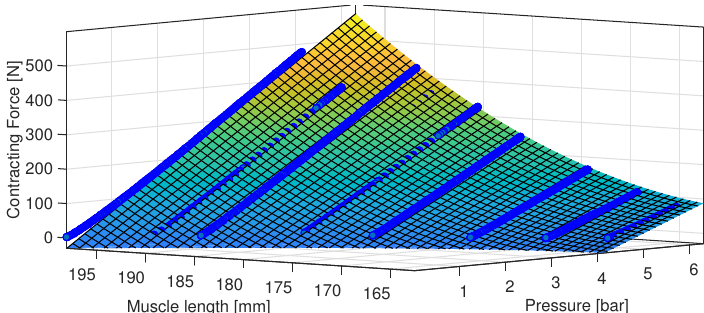
Figure 4. Representation of the identified force function f st ( l , p )